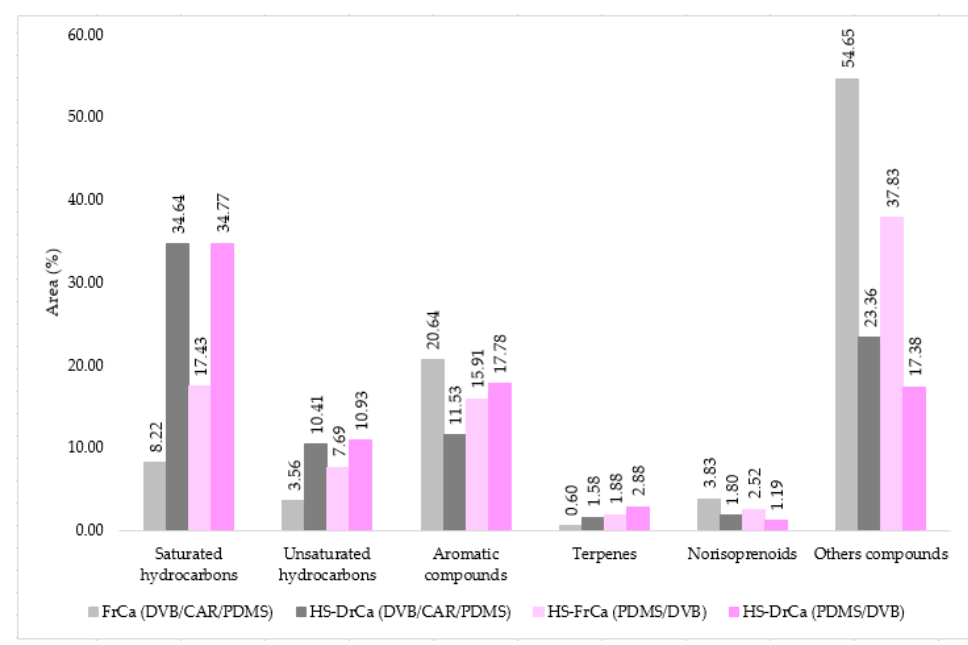
Figure 1. The VOCs from C. adhaerens sorted by structural groups extracted by HS-SPME.